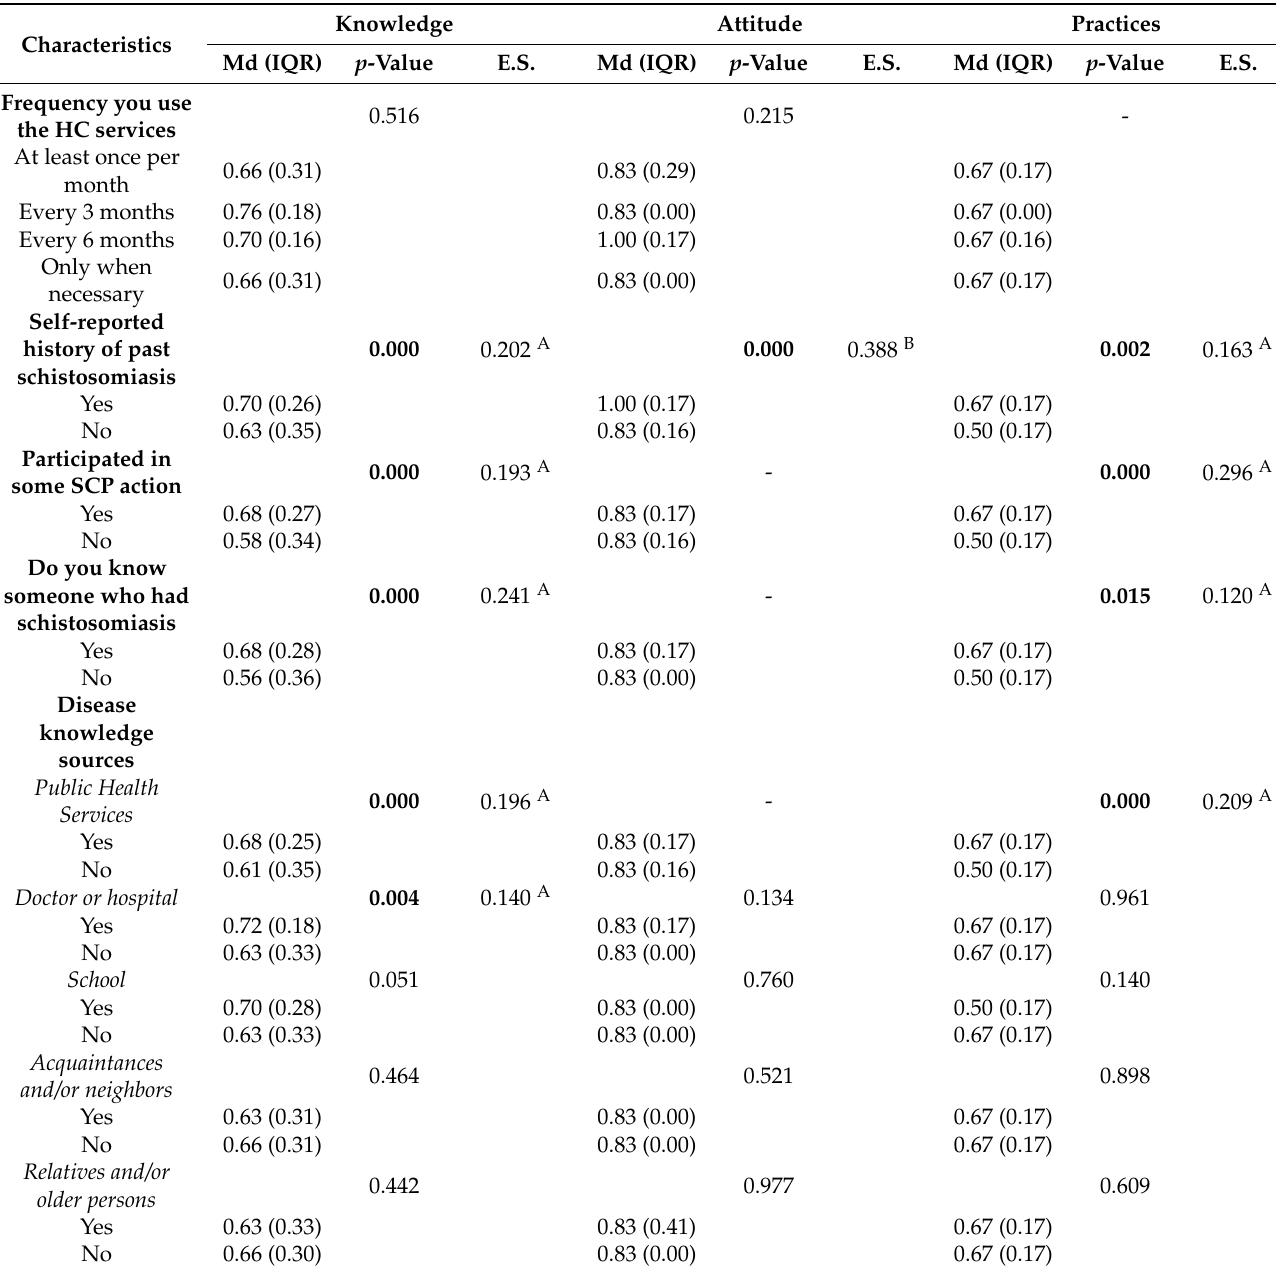
Table 4. Association of the scores of knowledge, attitudes and practices with the profile of health care demand and services among residents of Feira Grande, Alagoas, Brazil, in